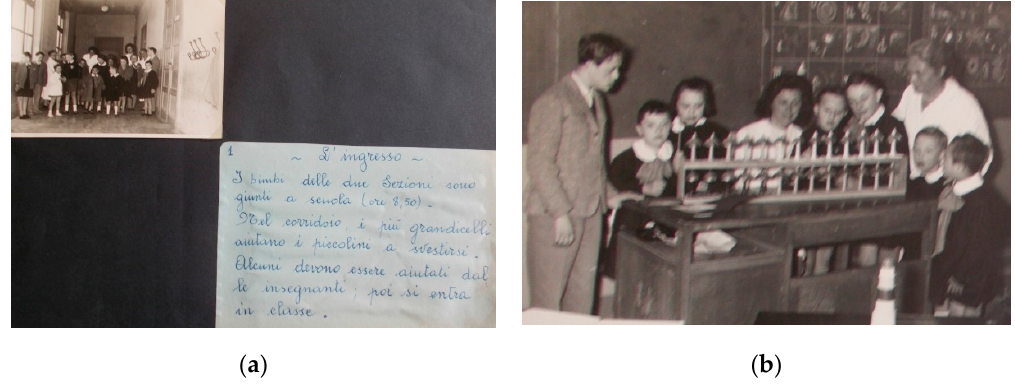
Figure 5. ( a ) e ( b ) Album about school life of Mongoloid section (ASPG, file